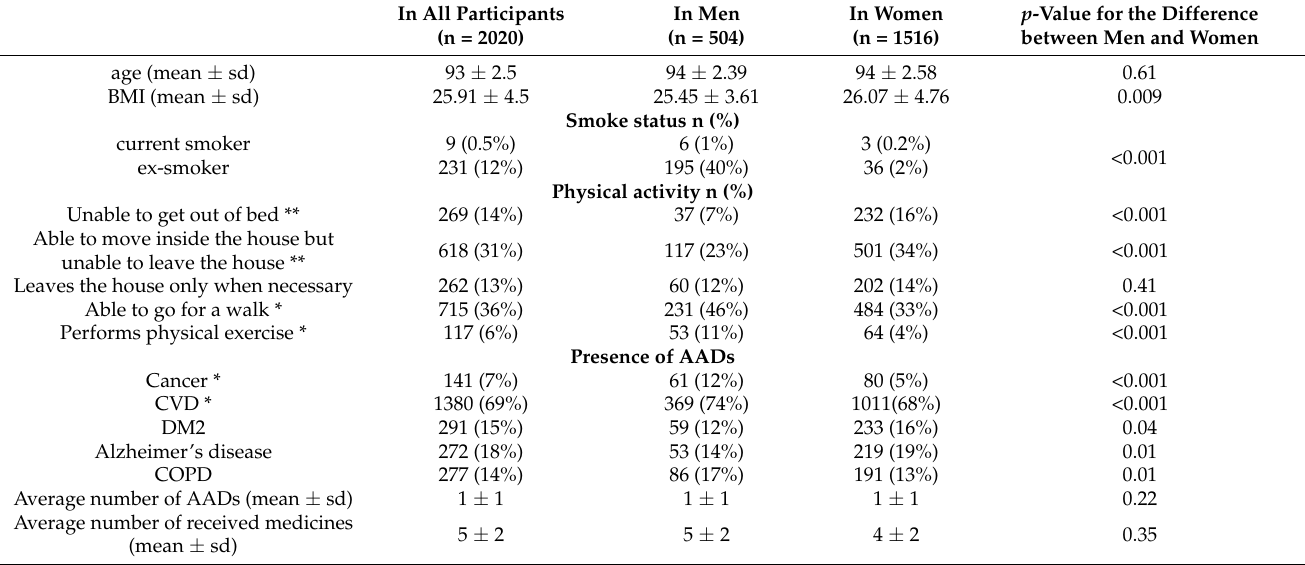
Table 1. Baseline characteristics of the participants and their distribution between men and